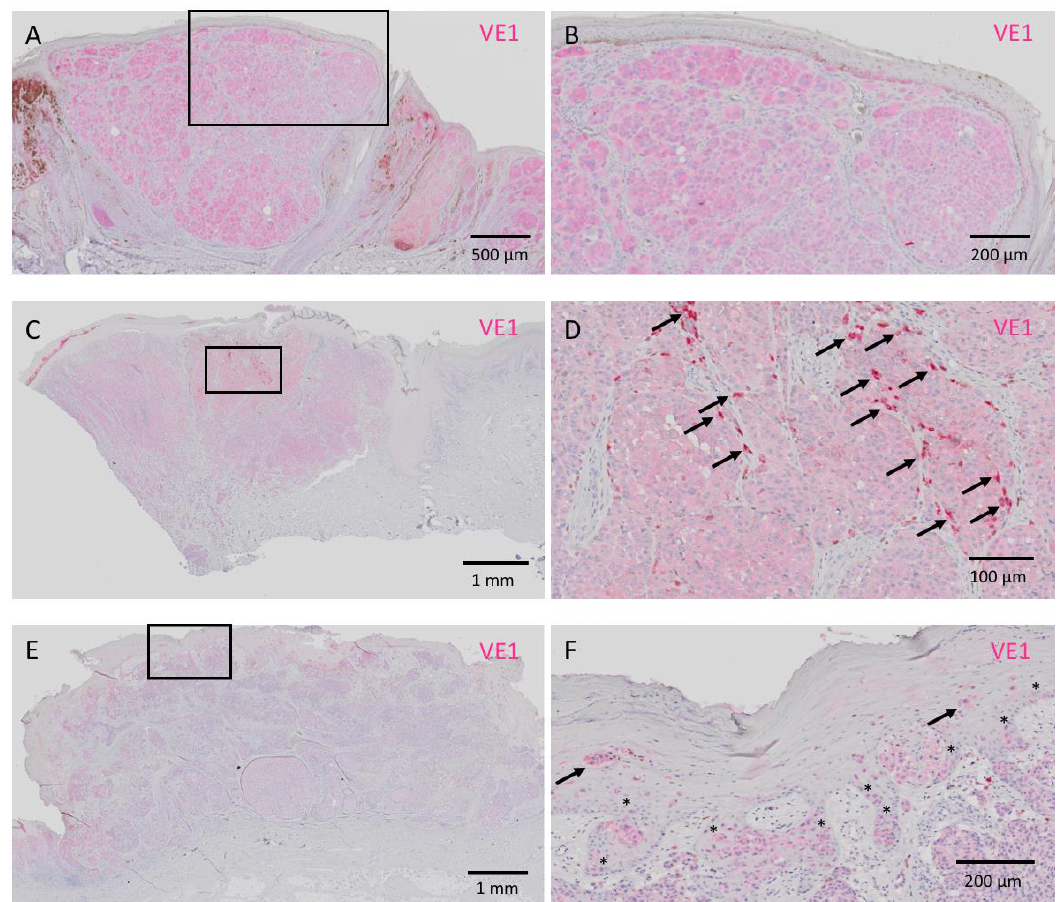
Figure 1 Figure 1. Three cases of acral melanomas with homogeneous VE1-positive staining. ( A ) Strong (3 + ) VE1 signals are evident. ( B ) High-powered view of the rectangular area in A . ( C ) Moderate (2 + ) VE1 staining of acral melanoma. ( D ) High-powered view of the rectangular area in C . Some tumor-infiltrating macrophages showing a strong red color (arrows) are noted. These macrophages should be excluded from the assessment of VE1 staining in melanoma. ( E ) Weak (1 + ) but definitely positive staining of VE1. ( F ) High-powered view of the rectangular area in E . Lentiginous spread of melanoma cells in the basal layer (*) is evident. Ascending melanoma cells (arrows) in the epidermis as well as melanoma cells in the dermis are also VE1 positive. Bars indicate 500 µ m in A , 200 µ m in B , F , 1 mm in C , E , and 100 µ m in D